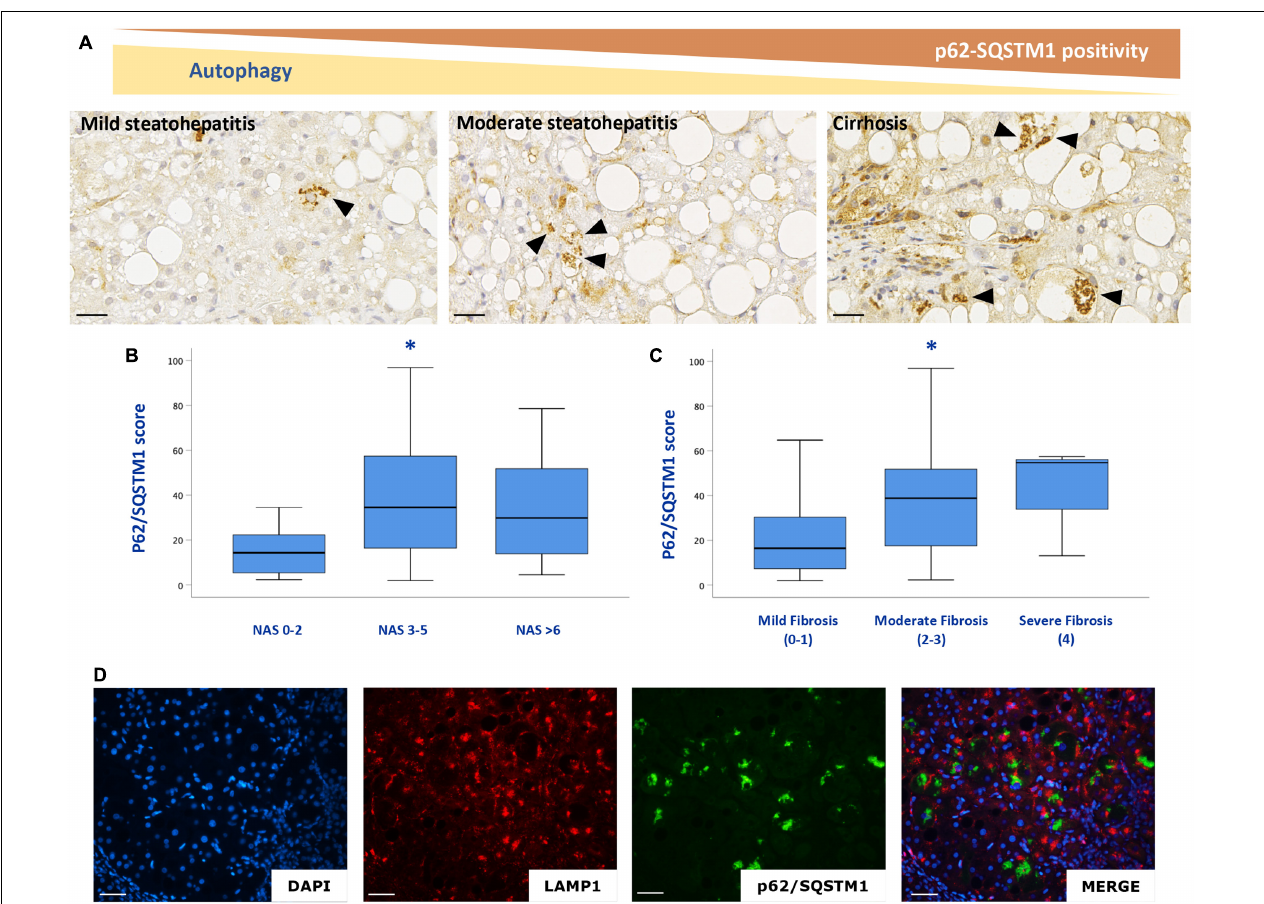
FIGURE 5 | p62/SQSTM1 accumulates with NAFLD progression (A–C) . P62/SQSTM1 positive Mallory-Denk bodies (arrowheads) were individuated in hepatocytes. Double labeling experiments with a lysosome marker (LAMP1, red) and autophagy impairment marker (p62/SQSTM1 green), confirmed that p62/SQSTM1 accumulates outside the lysosomes (D) . n = 59. Scale bar: 25 µ m; * = p < 0,05 vs. NAS 0–2 or mild fibrosis.